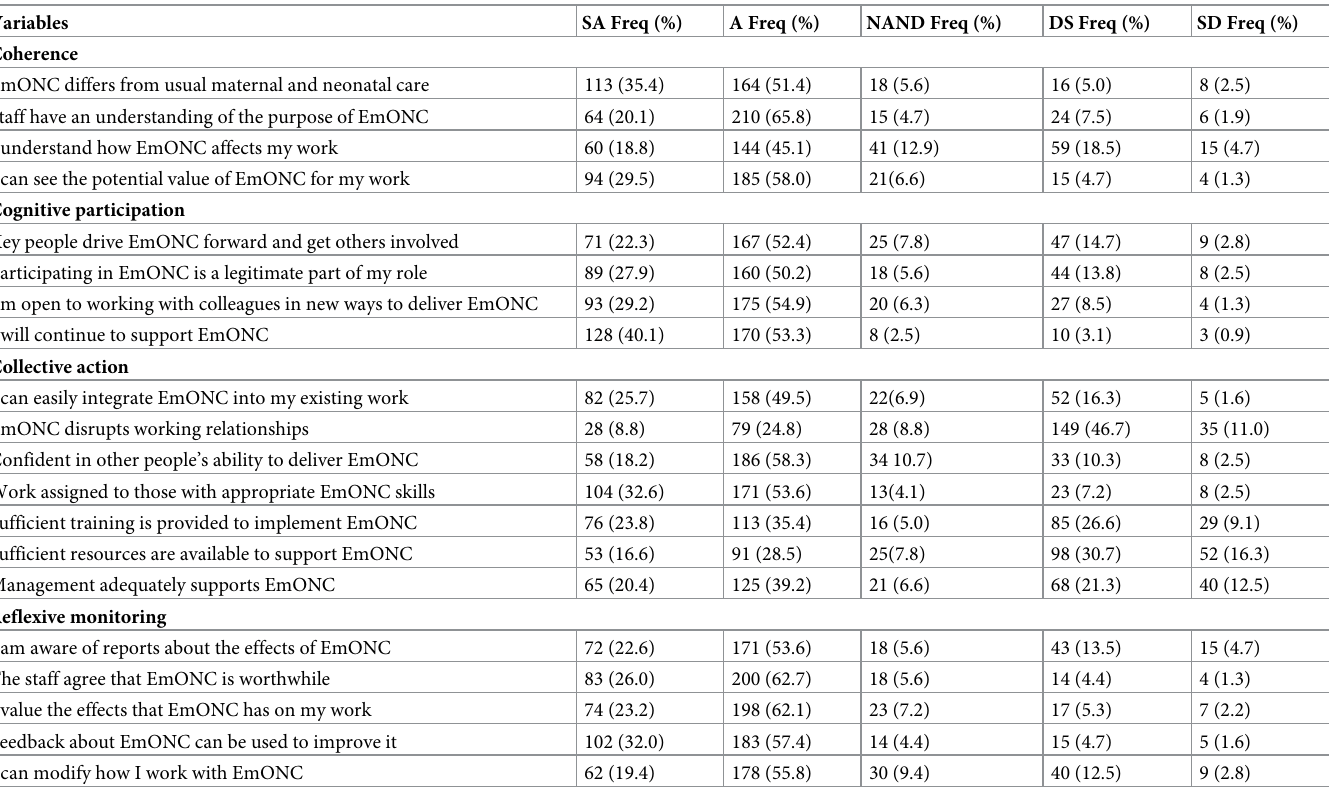
Table 2. Mechanism of integration of EmONC into maternal and newborn care in primary healthcare facilities (n =